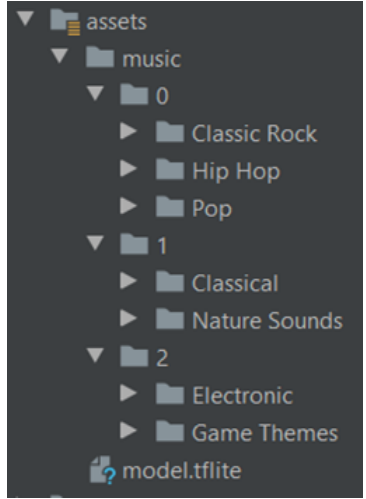
Figure 5. Architecture of assets